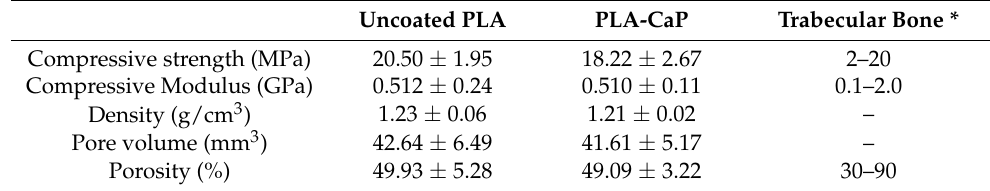
Table 2. Mechanical properties and Archimedes calculus values (n= 5 ± SD). * Bose et al., 2013